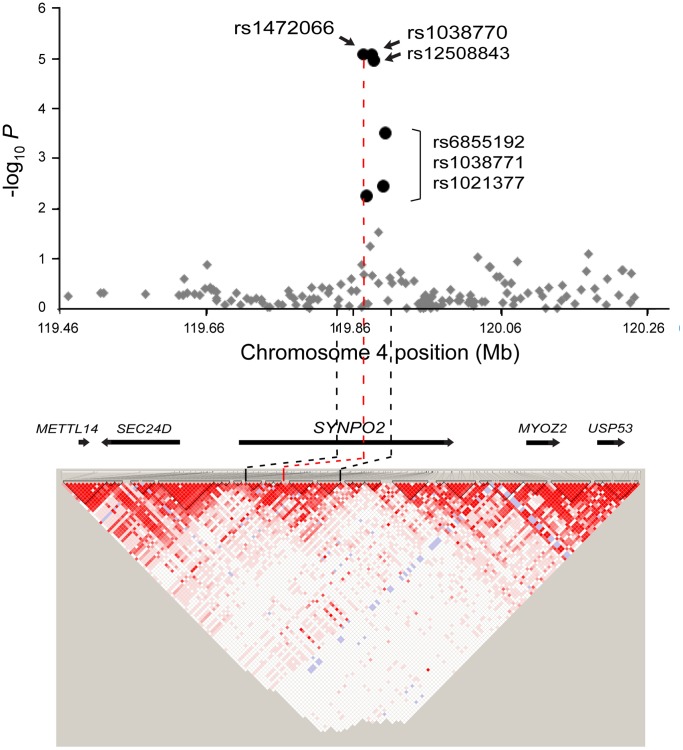
Regional association plot and LD of SYNPO2 for the total IgE in asthmatics.GWAS associations (-log10
P) of SNPs across approximately 768 kb region around SYNPO4 in the chromosome 4q26 are shown. Relatively strong associations are shown as large black circles; relatively less significances as small gray diamonds.